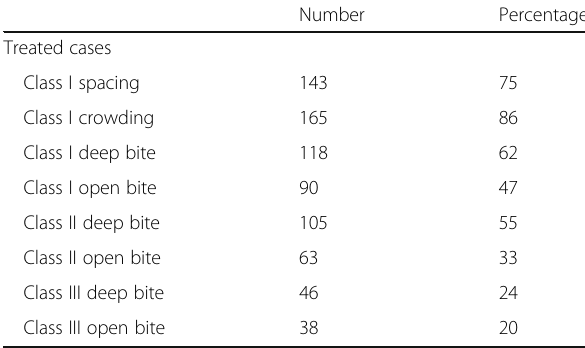
Table 4 Description of clear aligner cases treated by the total number of respondents Treated cases